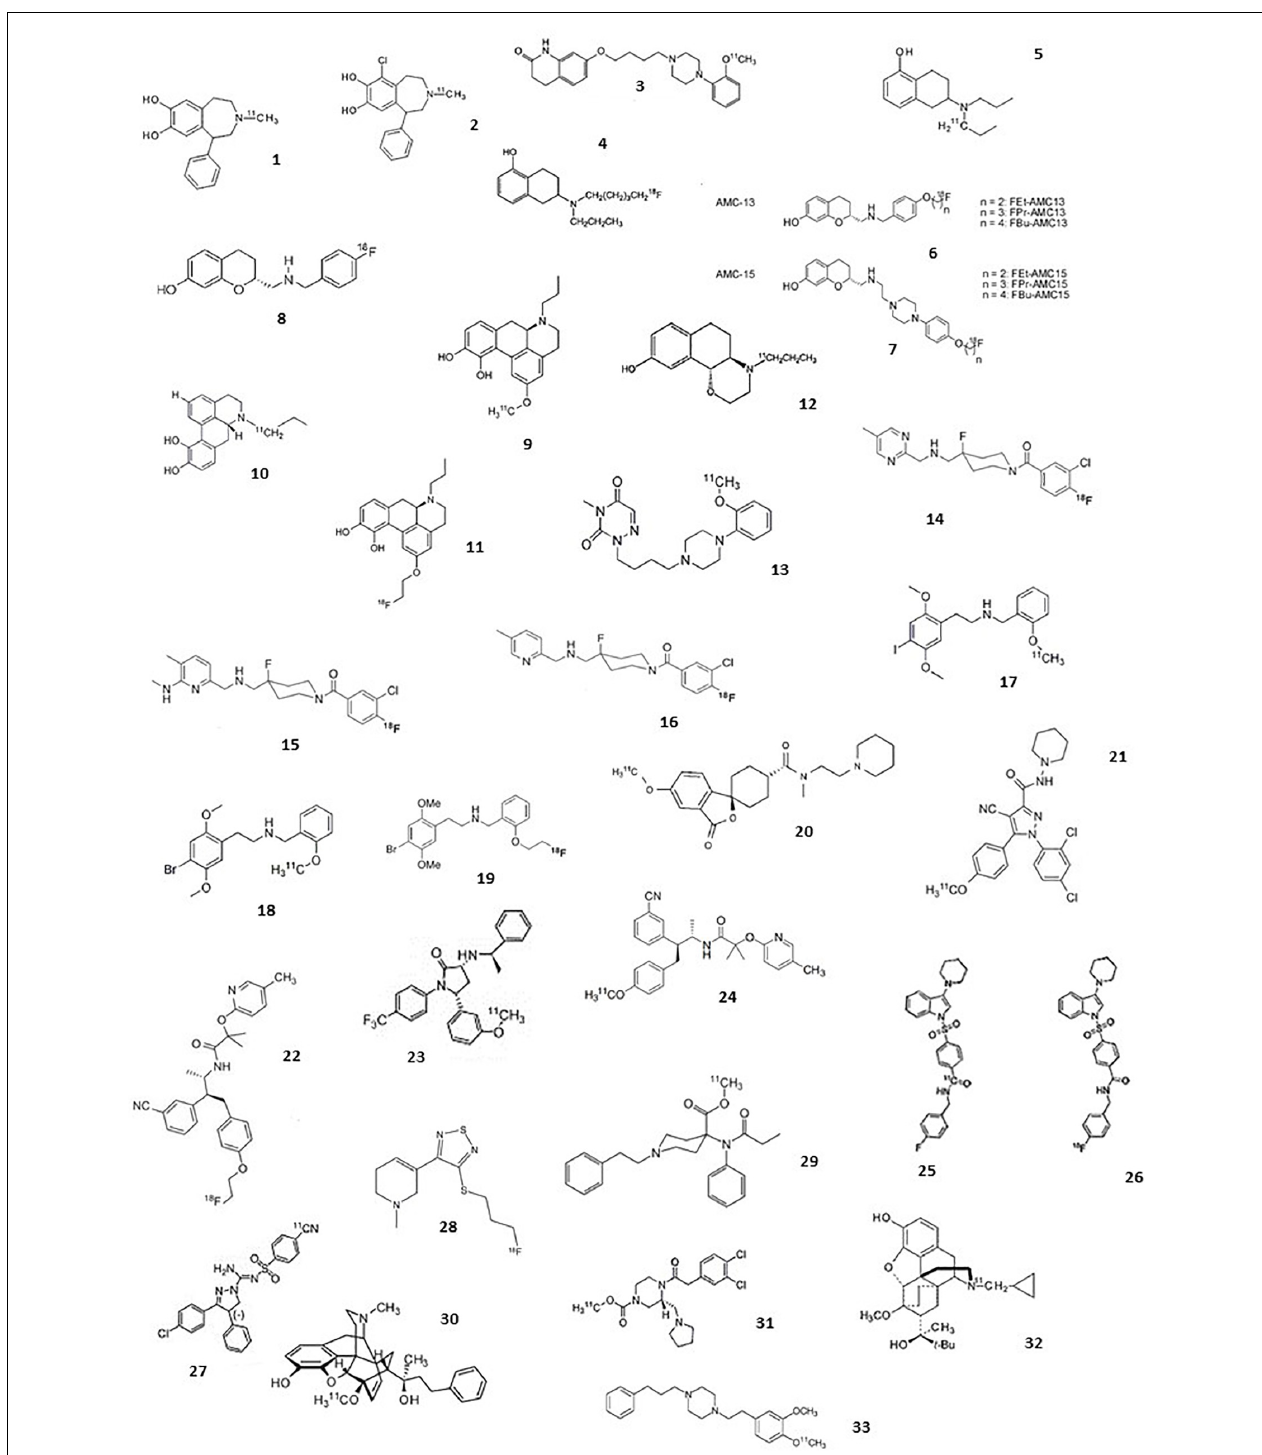
FIGURE 2 | Chemical structures of current agonist radiotracers of GPCRs. Dopamine receptors: (1) [ 11 C]SKF 82957, (2) [ 11 C]-SKF75670, (3) [ 11 C]SV-III-130, (4) [ 11 C]5-OH-DPAT, (5) [ 18 F]5-OH-FPPAT, (6) [ 18 F]FBu-AMC13 and derivatives, (7) [ 18 F]FEt-AMC15 and derivatives, (8) [ 18 F]AMC20, (9) [ 11 C]NPA, (10) [ 11 C]MNPA, (11) [ 18 F]MCL-524, (12) [ 11 C]PHNO; serotonin receptors: (13) [ 11 C]CUMI-101, (14) [ 18 F]F15599, (15) [ 18 F]F13714, (16) [ 18 F]F13640, (17) [ 11 C]Cimbi-5, (18) [ 11 C]Cimbi-36, (19) [ 18 F]FECimbi-36; histamine receptors: (20) [ 11 C]MK-8278; cannabinoid receptors: (21) [ 11 C]OMAR or [ 11 C]JHU75528; (22) [ 18 F]MK-9470, (23) [ 11 C]MePPEP, (24) [ 11 C]CB-119, (25) [ 11 C]PipISB, (26) [ 18 F]PipISB, (27) [ 11 C]SD5024; acetylcholine receptors: (28) [ 18 F]FP-TZTP; Opioïd receptors: (29) [ 11 C]carfentanil, (30) [ 11 C]PEO, (31) [ 11 C]GR103545, (32) [ 11 C]buprenorphine; Sigma 1 receptors: (33) [ 11